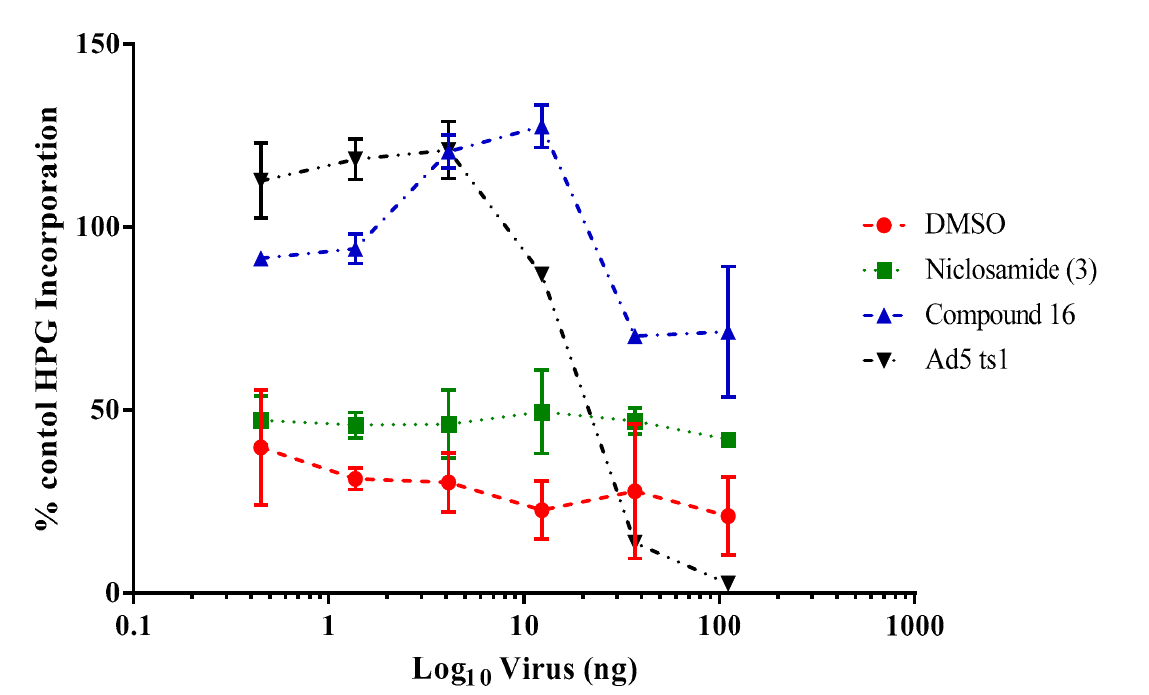
Figure 6. Activity of compound 16 on HAdV-mediated endosomolysis in a α -sarcin assay. The concentrations used were 5 µ M for niclosamide (3) and 10-fold IC 50 concentration obtained in the plaque assay for derivative 16. Results represent means ± SD of triplicate assays.